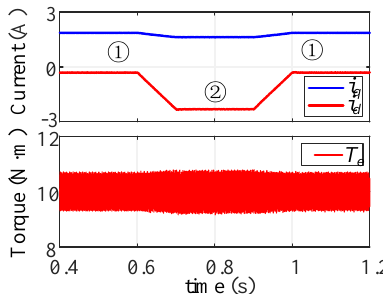
Figure 3. Numerical results for the currents and torque using the proposed method.